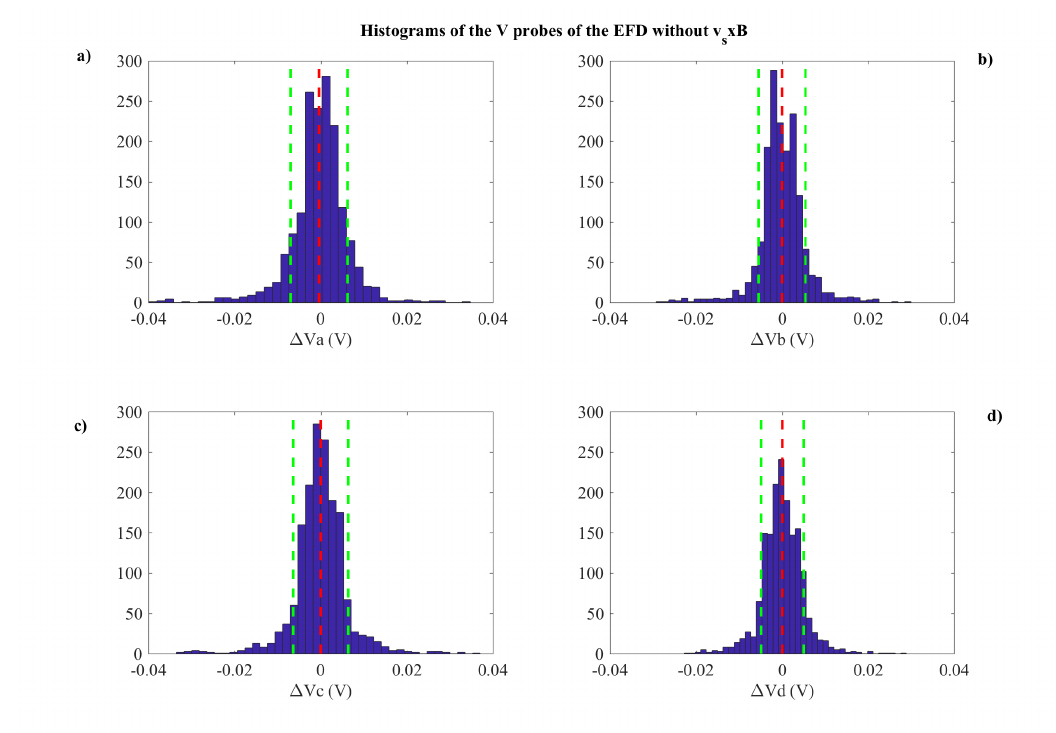
Figure 4. Distributions of the differences between probe potential V i and the expected value V theo for the various probes in the quiet period. Panel labels (a, b, c, and d) indicate the probe used to compute the difference with the theoretical value. Red vertical dashed lines indicate the mean value. Green vertical dashed lines indicate values at +/ − one